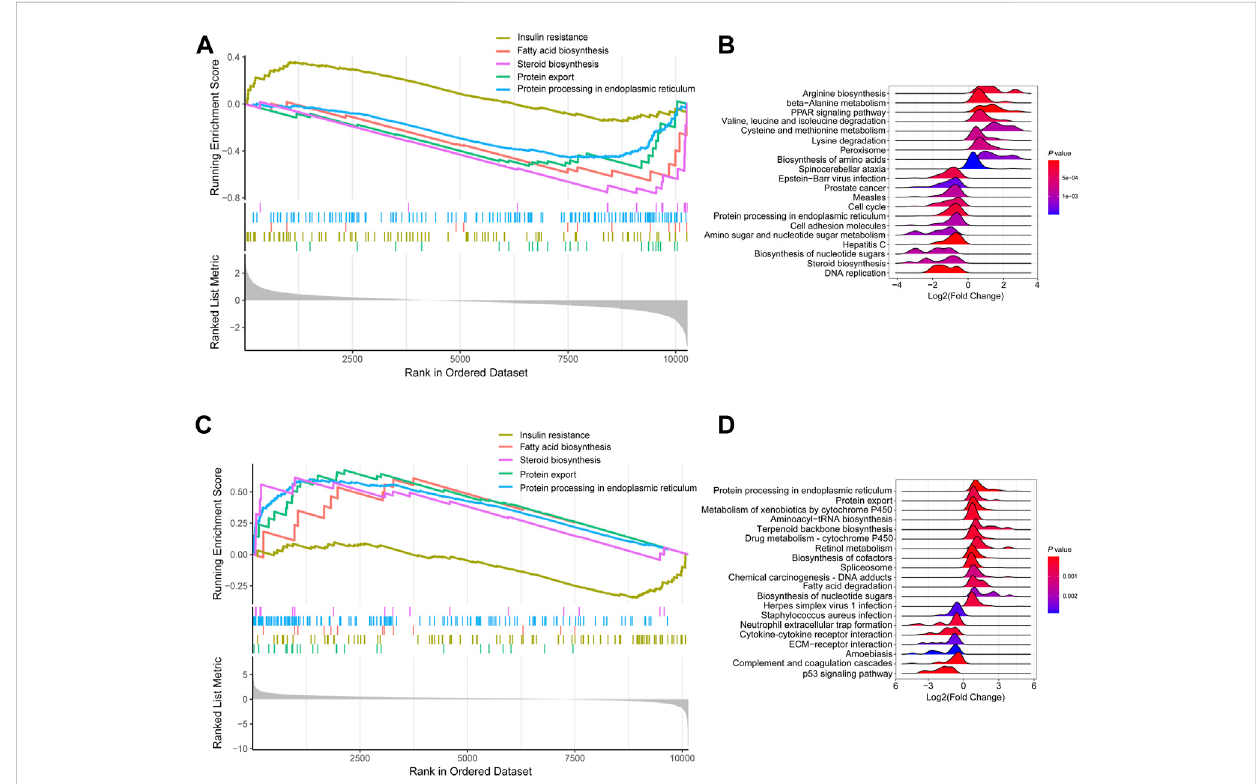
FIGURE 3 KEGG signaling enrichment analysis of mRNA expression pro fi le based on GSEA. (A,B) KEGG signaling enrichment analysis of mRNA expression pro fi le in fasted versus fed cohort. (A) Selected GSEA results of mRNA expression pro fi le in fasted versus fed cohort. Running enrichment score and ranked list are presented. (B) Ridge plot listed the top 20 pathways in fasted versus fed cohort. (C,D) KEGG signaling enrichment analysis of mRNA expression pro fi le in refed versus fasted cohort. (C) Selected GSEA results of mRNA expression pro fi le in refed versus fasted cohort. Running enrichment score and ranked list are presented. (D) Ridge plot listed the top 20 pathways in refed versus fasted